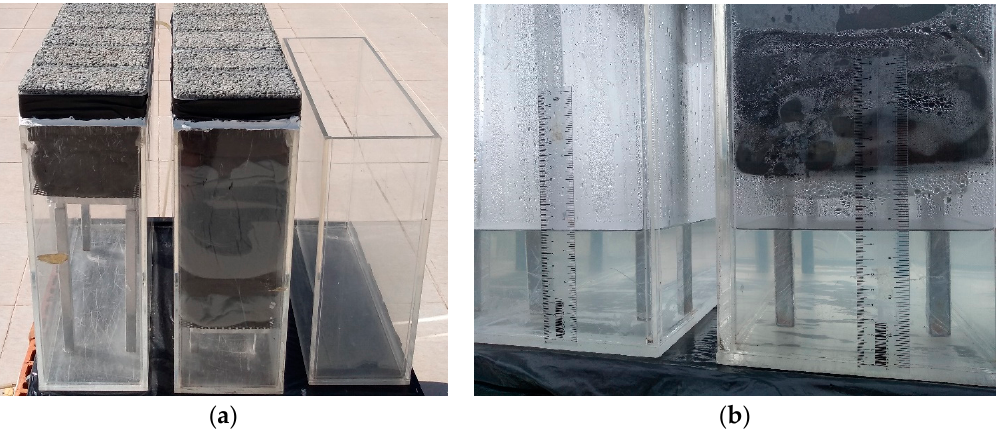
Figure 4. Model systems exposed to rain events. ( a ) Model systems and the control box; ( b ) Infiltrated rainwater measure.